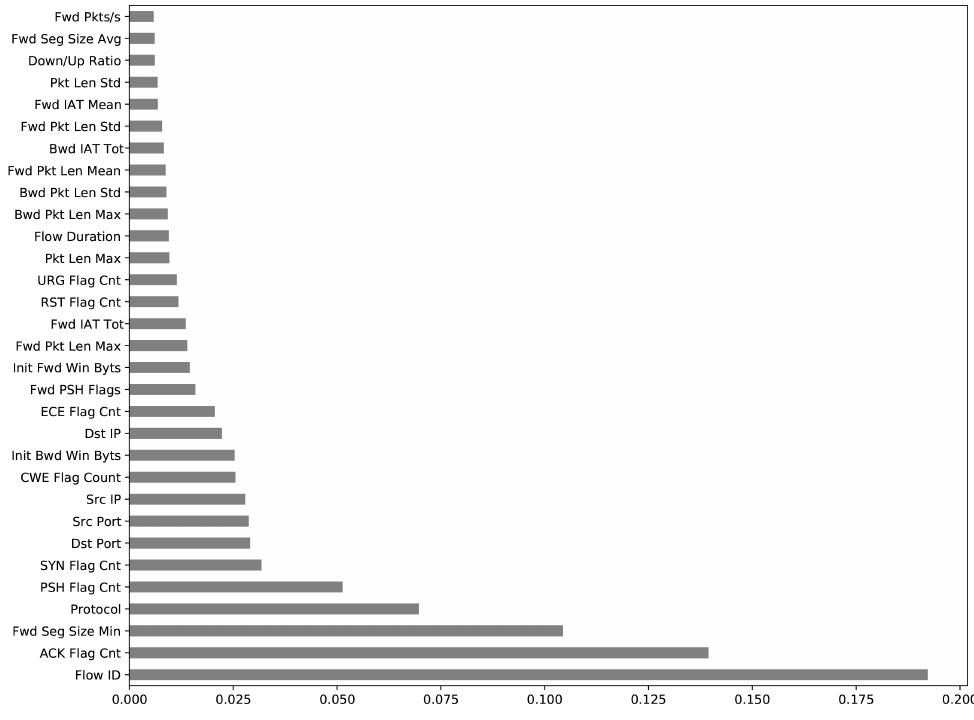
Figure 5. Combined dataset ranked features.